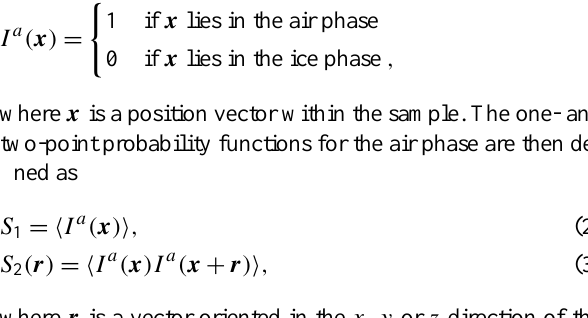
) + φ 2 with β = ( x , y , z β